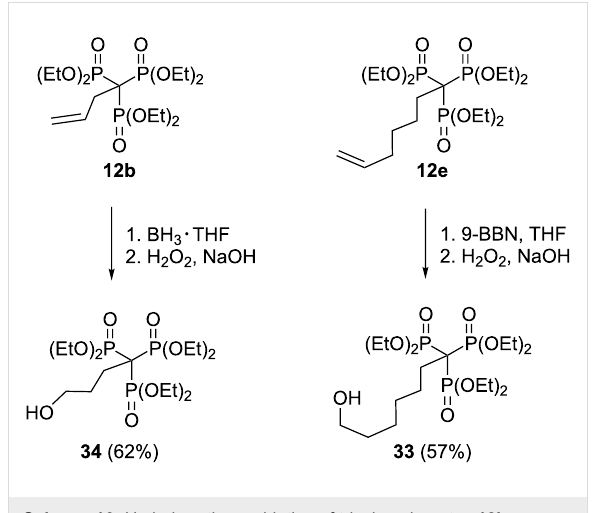
Scheme 16: Hydroboration–oxidation of trisphosphonates 12b , e